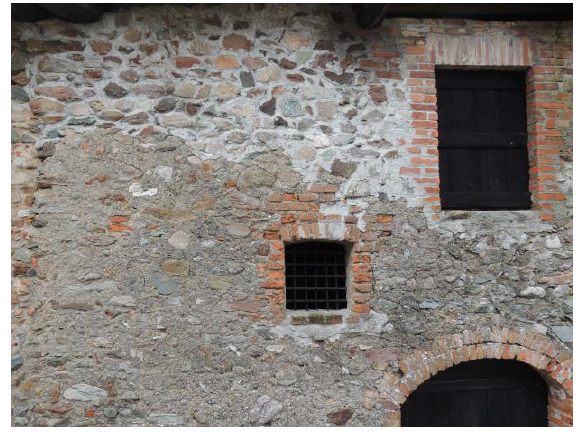
Figure 11. Building B - Reintegration of the masonry adopting inappropriate materials (credits Fabio Fratini).